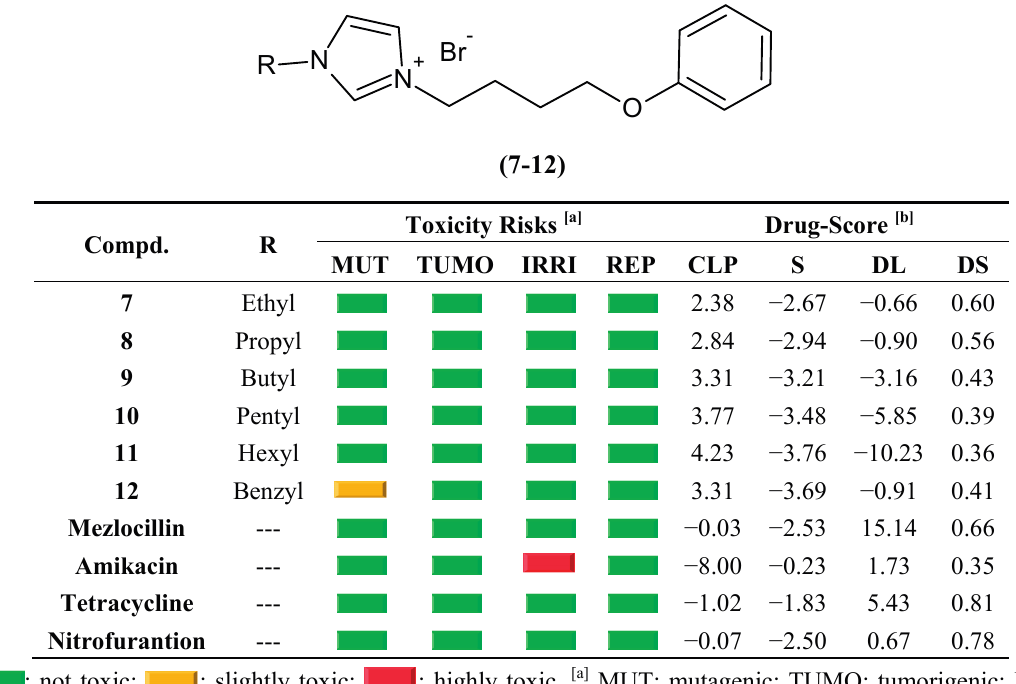
Table 4. Osiris calculations of toxicity risks and drug-score of compounds 7 – 12 .